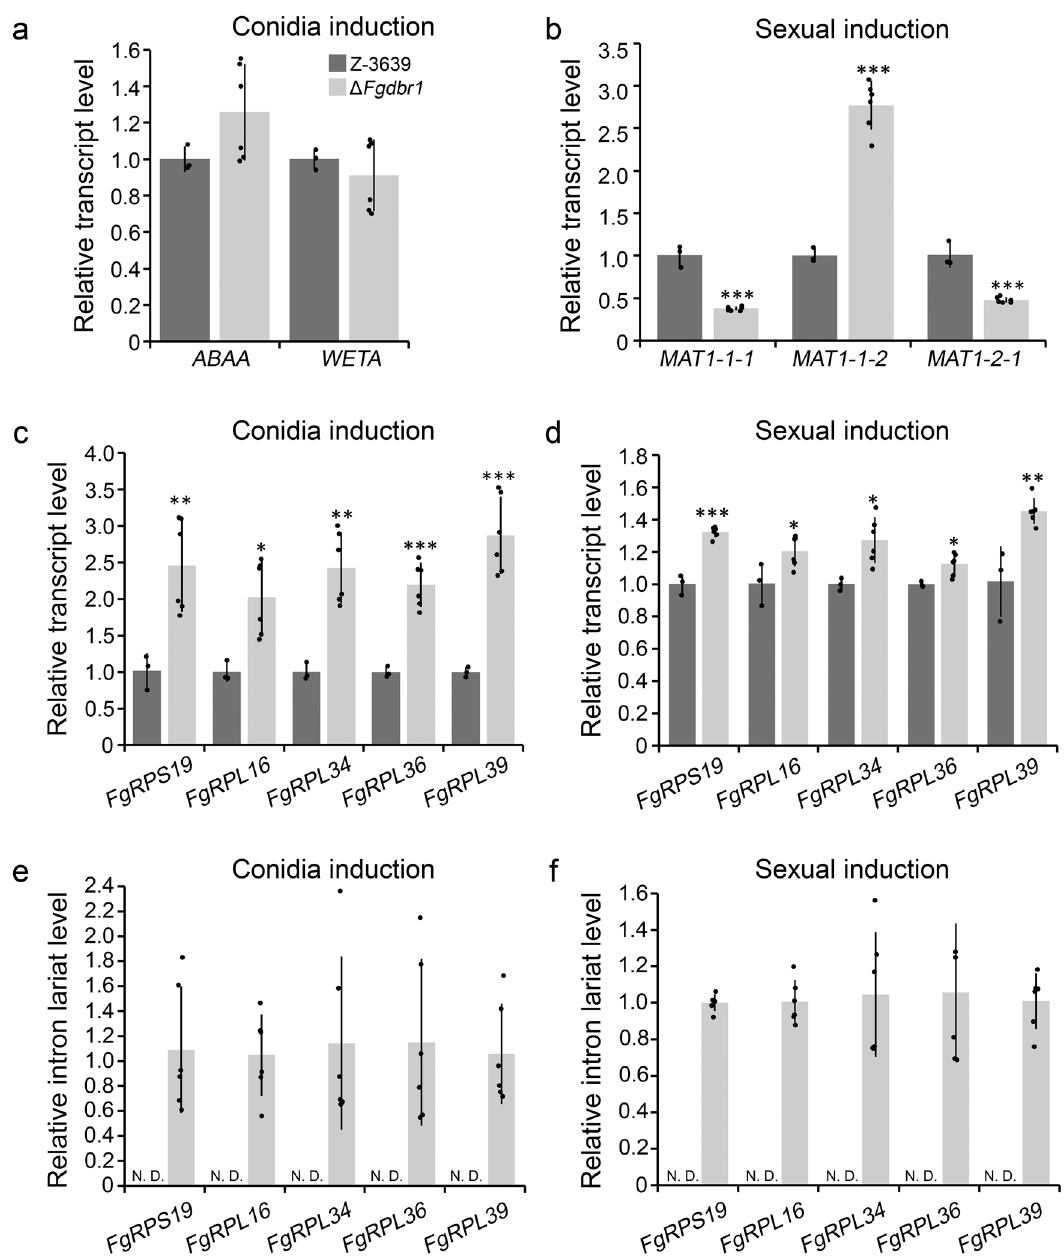
Fig. 8 Effects of accumulated intron lariats on the transcript levels of conidiation related, mating-type genes, and ribosomal components. a Transcript levels of genes related to conidiation in the wild-type and Δ Fgdbr1 strains. Transcript levels were quanti fi ed by qRT-PCR 12 h after conidia induction on YMA. b Transcript levels of mating-type genes in the wild-type and Δ Fgdbr1 strains. Transcript levels were quanti fi ed by qRT-PCR 2 days after sexual induction. c , d Transcript levels of ribosomal protein genes in the wild-type and Δ Fgdbr1 strains during conidia ( c ) and sexual induction ( d ). e , f Relative intron lariat levels in the wild-type and Δ Fgdbr1 strains during asexual ( e ) and sexual development ( f ). Error bars represent standard deviations of biological replicates ( n = 3 for wild type, n = 6 for Δ Fgdbr1 ). * p < 0.05; ** p < 0.01; *** p < 0.001. N.D. not